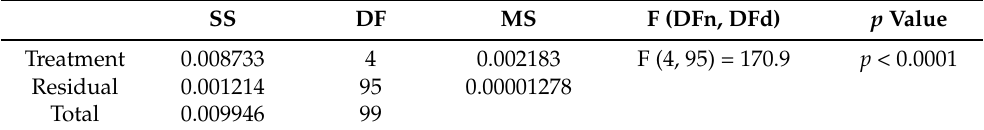
Table 13. One-way analysis of variance test of the achieved results using the second dataset